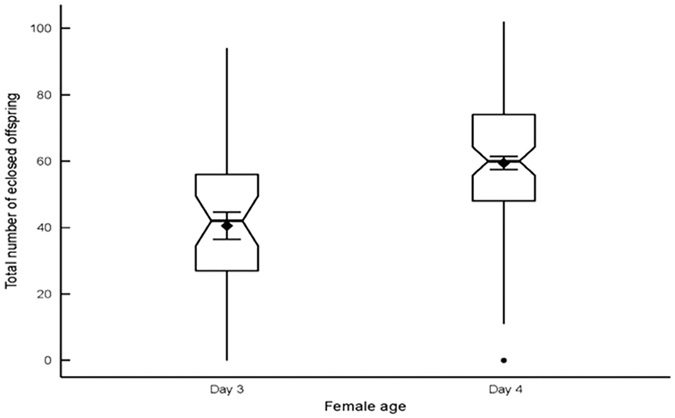
Effect of female age of mating (three days vs. four days) on total number of eclosed offspring (means [diamond symbol] ± SE displayed inside box plots).